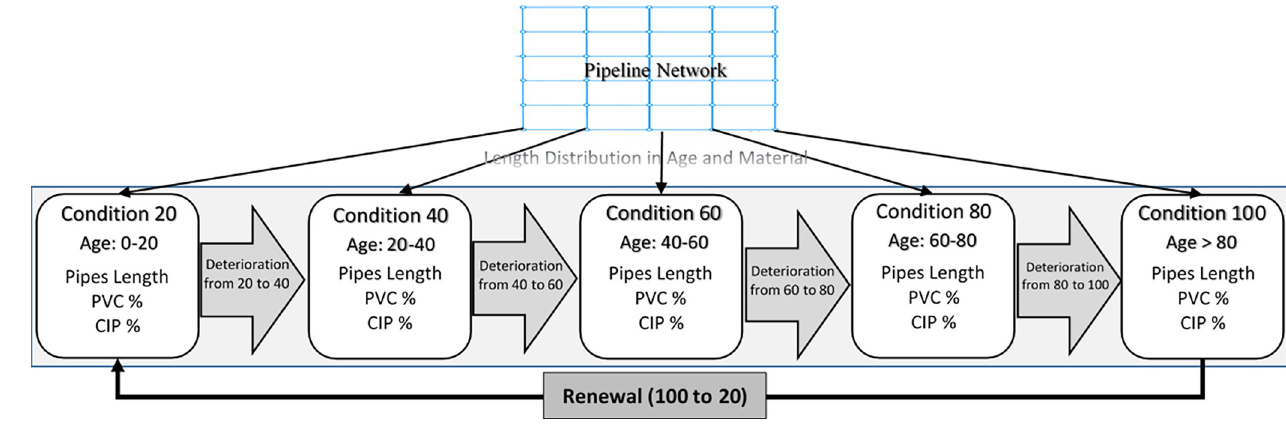
Fig 5. Modeling physical pipeline deterioration